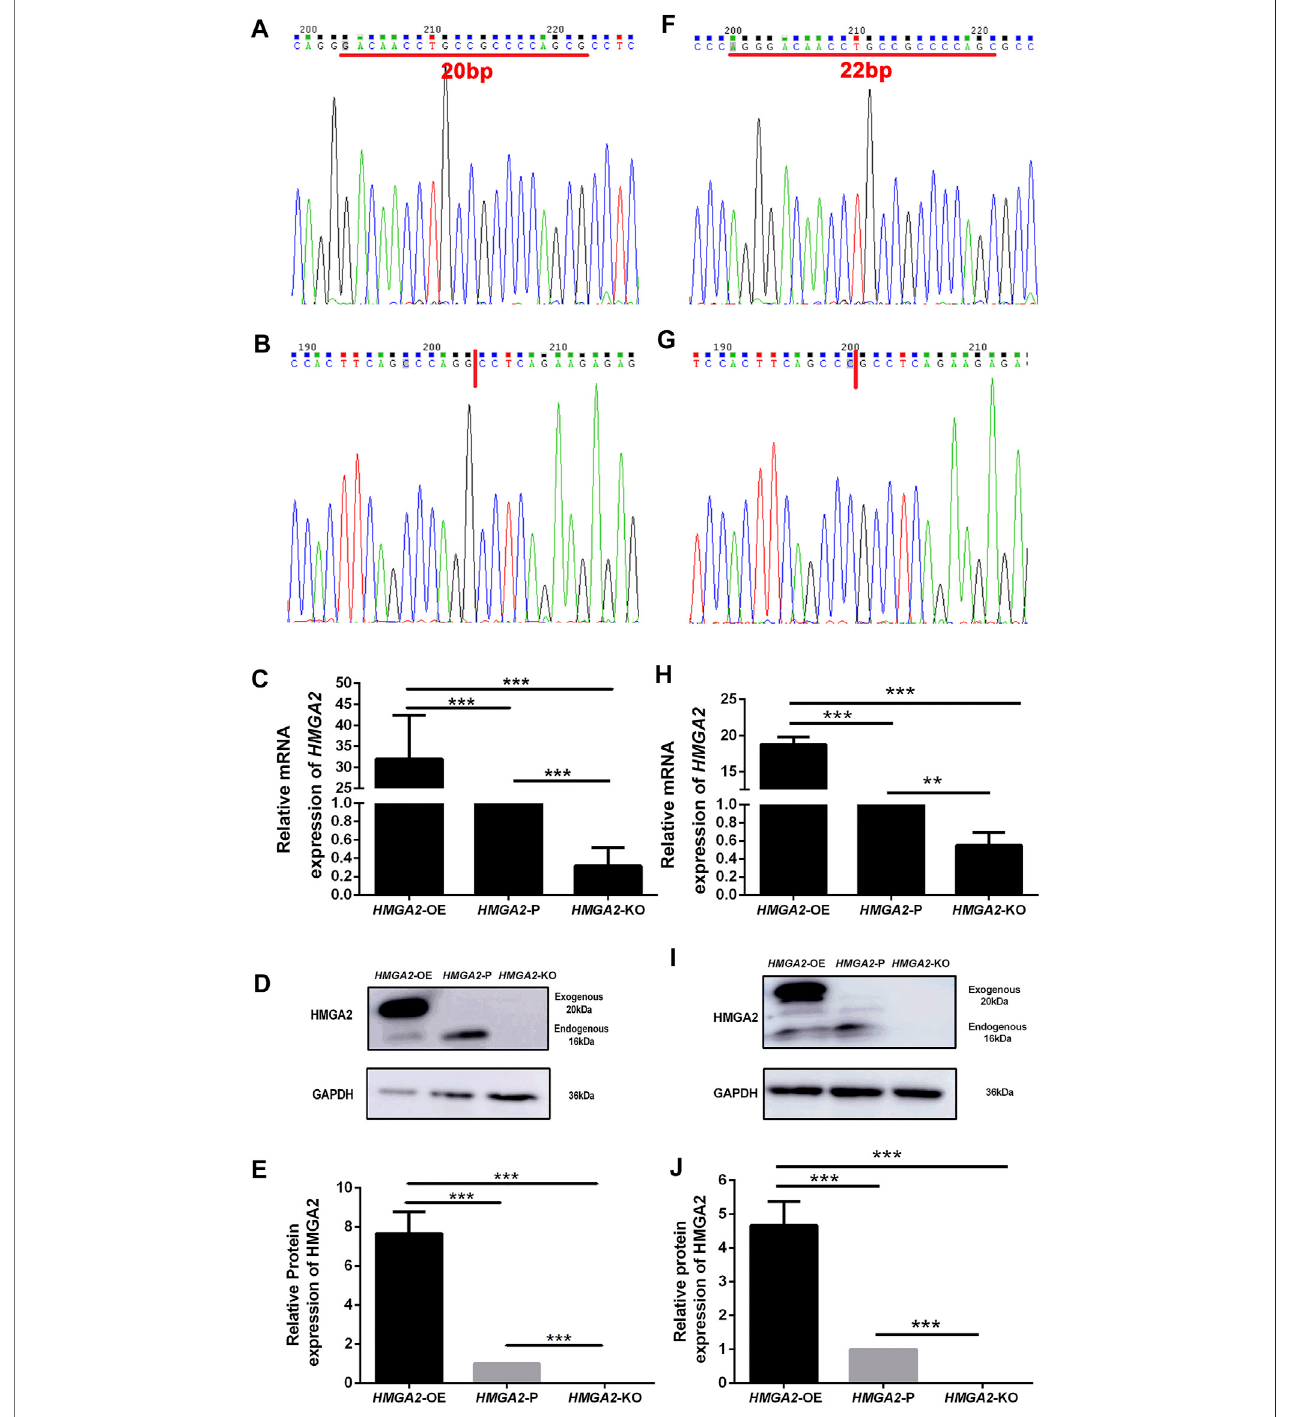
FIGURE 1 | HMGA2 was knocked out in a biallelic manner and overexpressed successfully in two human gastric cancer cell lines. Sanger sequencing results of HMGA2 in HMGA2 -P MKN-45 (A) , HMGA2 -KO MKN-45 (B) , HMGA2 -P MGC-803 (F) , and HMGA2 -KO MGC-803 (G) . Red lines in (A) and (F) indicate the deleted bases of HMGA2 in HMGA2 -KO MKN-45/MGC-803, respectively. The expressions of HMGA2 in the mRNA level in HMGA2 -edited MKN-45 cells (C) and MGC-803 cells (H) were detected. The expressions of HMGA2 in the protein level in HMGA2 -edited MKN-45 cells (D,E) and MGC-803 cells (I,J) are shown. *** p < 0.001, Student ’ s t-test. The error bars represent